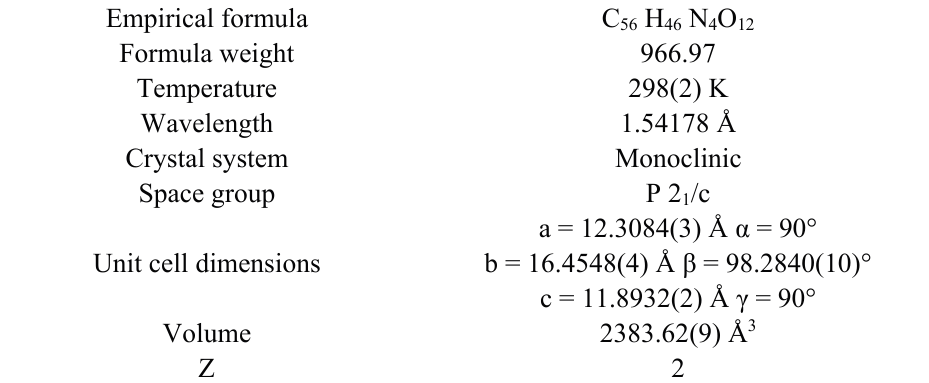
Table 2. Crystal data and structure